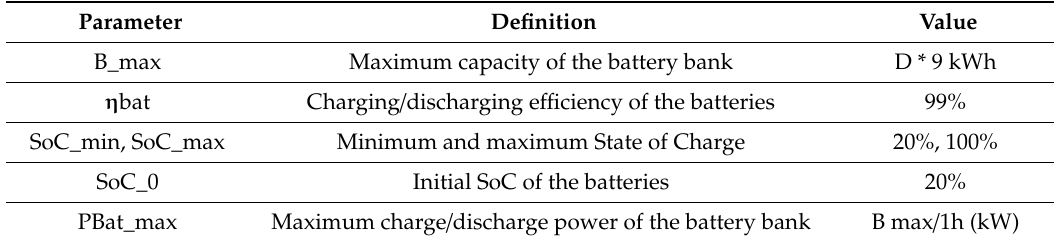
Table 3. Parameters related to energy storage.